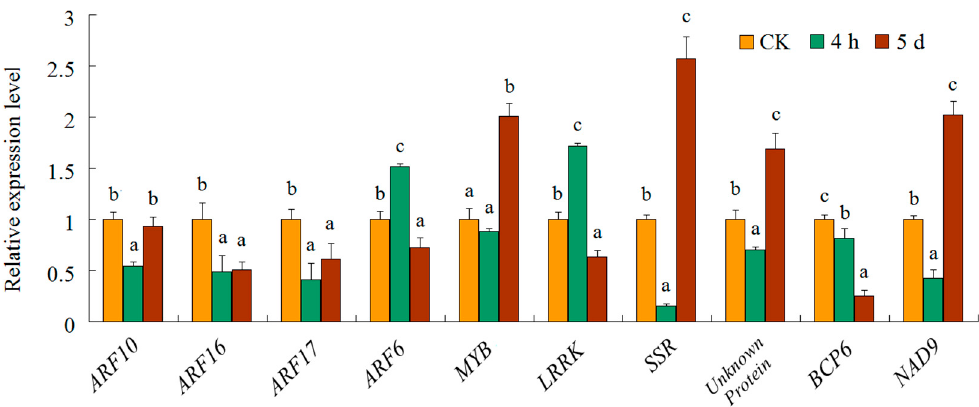
Figure 6. Target plot (t-plot) for target genes of less-conserved miRNAs. Arrows indicate the signatures corresponding to the miRNA cleavage site. Partial mRNA sequences of target genes aligned with the miRNAs show perfect matches (straight lines), G-U wobbles (circles).